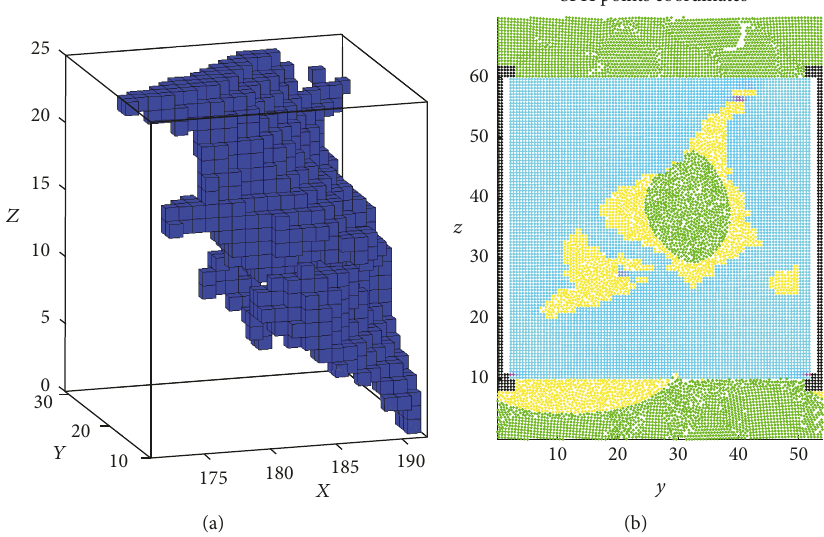
Figure 8: (a) A disconnected pore component 𝜀 = 0.0017 extracted from 192 × 184 × 25 sample. (b) A cross-section ( 38ℎ < 𝑥 < 39ℎ ) of the unit cell obtained from 385 × 369 × 51 sample during drainage simulation. Green points correspond to gas particles, yellow points to water particles, and black points to rigid phase particles; other colors reflect relative variation of stress inside the elastic